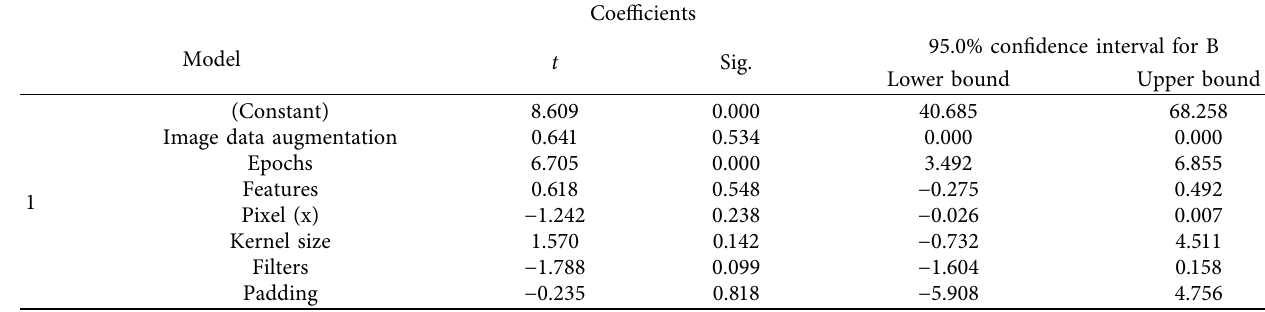
Table 2: Coefficient